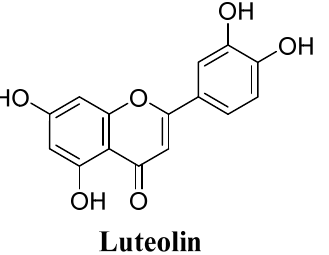
Figure 8. Luteolin. Nobiletin is a citrus flavones and chemically known as 5,6,7,8,3 ′ ,4 ′ -hexamethoxyflavone (Figure 9). This flavone has been reported to exert neuroprotective effects against β -amyloid peptide-induced neuronal death in hippocampal CA1 region, cognition impairment and also reduced level of β -amyloid peptides [65]. The anti-depressant potential of nobiletin isolated from orange peel was studied in animal models, i.e., forced swim and tail suspension test; and found to significantly inhibit depressive-like behaviors. This anti-depressant action of nobiletin was suggested to be umpired via interaction with noradrenergic ( α 1-adrenoceptor), dopaminergic (D1 and D2- receptors) and serotonergic (5-HT1A and 5-HT2- receptors) systems [66].